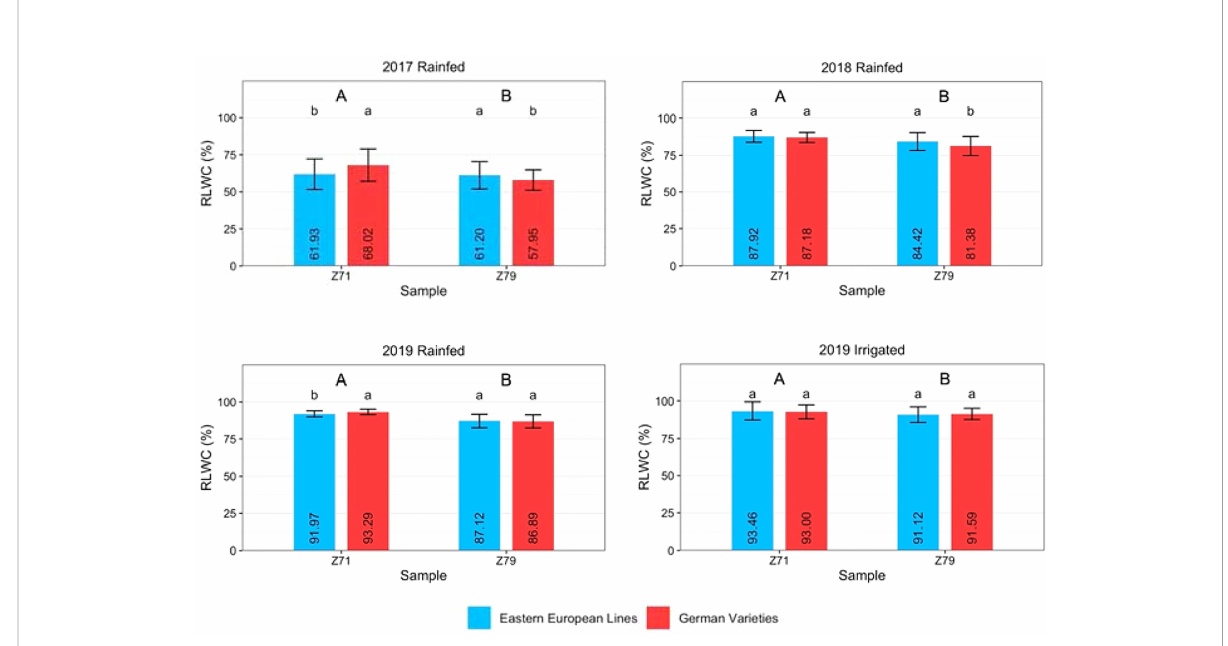
FIGURE 4 Relative leaf water content (RLWC) of Eastern European lines and German varieties measured at growth stages Z71 and Z79 under rainfed conditions in 2017, 2018, and 2019 and under irrigated conditions in 2019. The vertical bars indicate the standard deviation of the mean. Capital letters indicate signi fi cant differences between the years, small letters indicate signi fi cant differences between origins within one year.